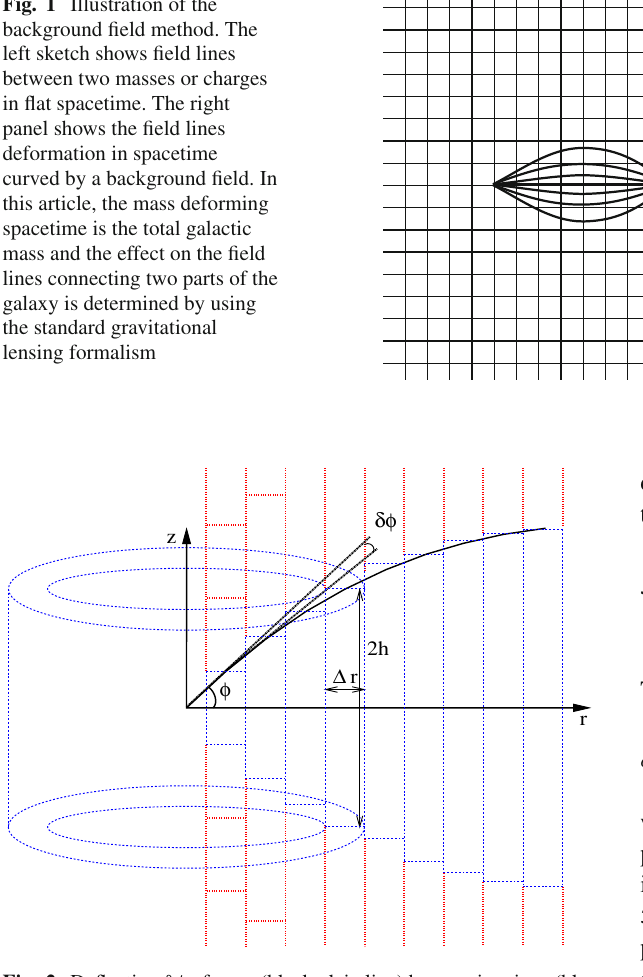
Fig. 2 Deflection δφ of a ray (black plain line) by massive rings (blue dashed lines and red dotted lines) of thickness (cid:4) r and height 2 h , sym- metric around the z axis and the horizontal z = 0 plane. One ring is represented, as well as the cross-sections of the others (rectangles). In addition to the central rings (i.e. of mid-plane at z = 0, represented with blue dashed lines), other rings above + h and below − h (their rect- angular cross-sections are shown with red dotted lines) also contribute to the deflection, although their total effect largely cancels. The step (cid:4) r is small compared to the galactic characteristic radial scale h height h is determined at each step by the bent